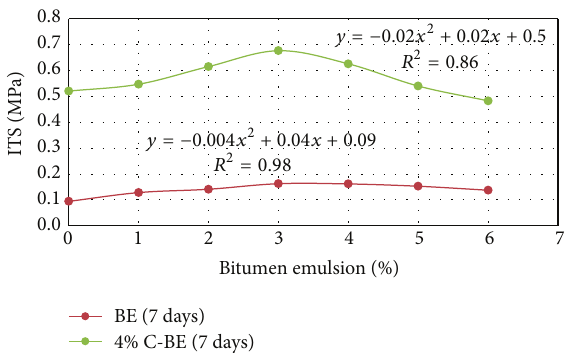
Figure 2: Influence of cement content on MS of CTB.